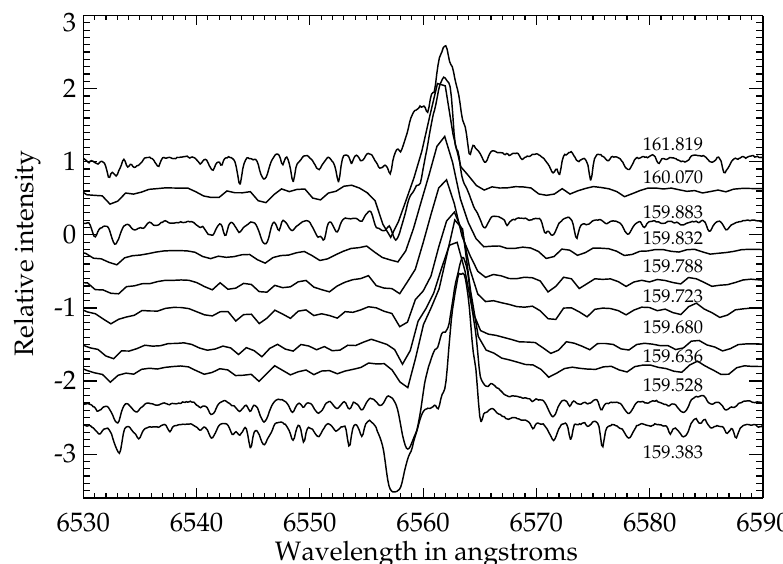
Fig. 8. The same as in Figure 7 but for cycles 159{161. The strong blue absorption is clearly visible at the phase